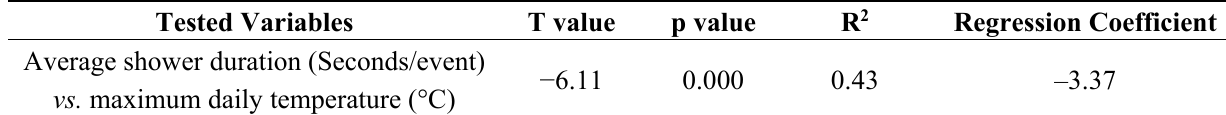
Table 7. Results of the regression analysis between average shower duration and maximum daily temperature.